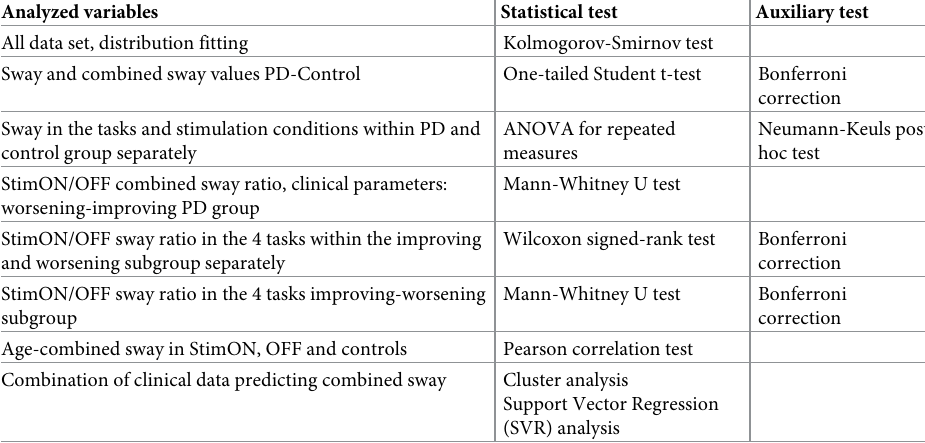
Table 1. Summary of the performed statistical tests.